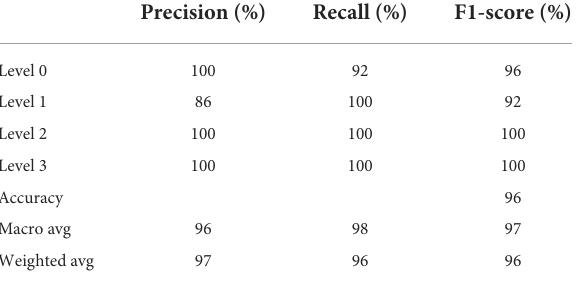
TABLE 4 The classification report of the proposed approach on the rockburst database.